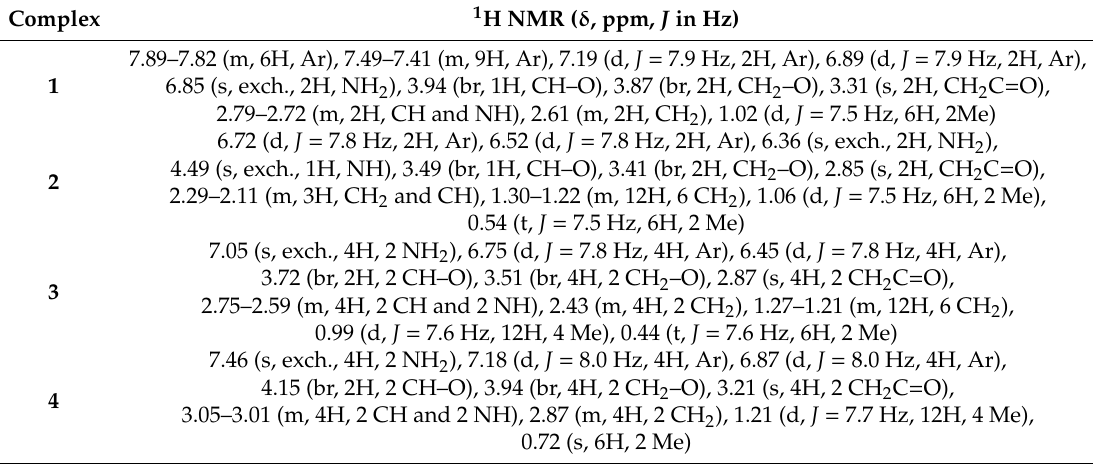
Table 3. 1 H NMR data (500 MHz) for complexes 1–4